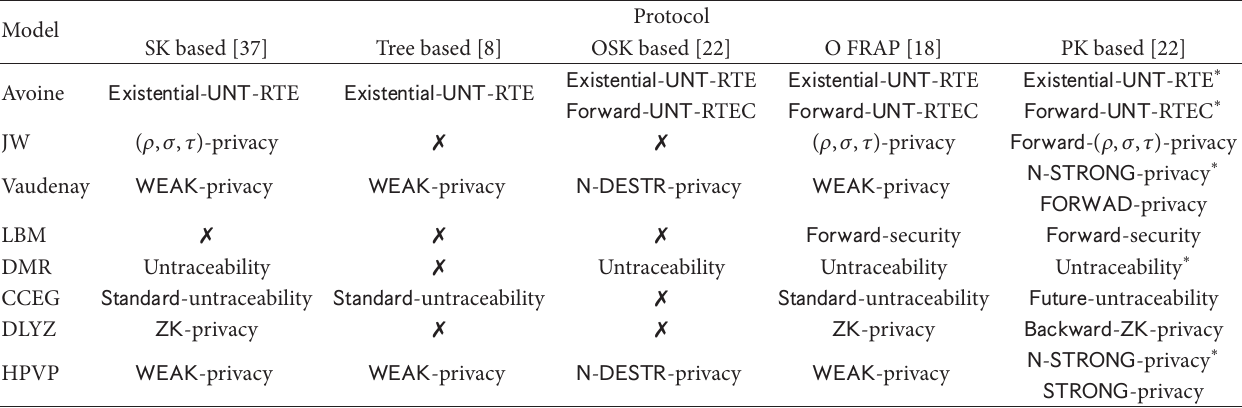
T 2: Comparison of the presented privacy models. “ . “N/A” means that the feature is not applicable in the model.